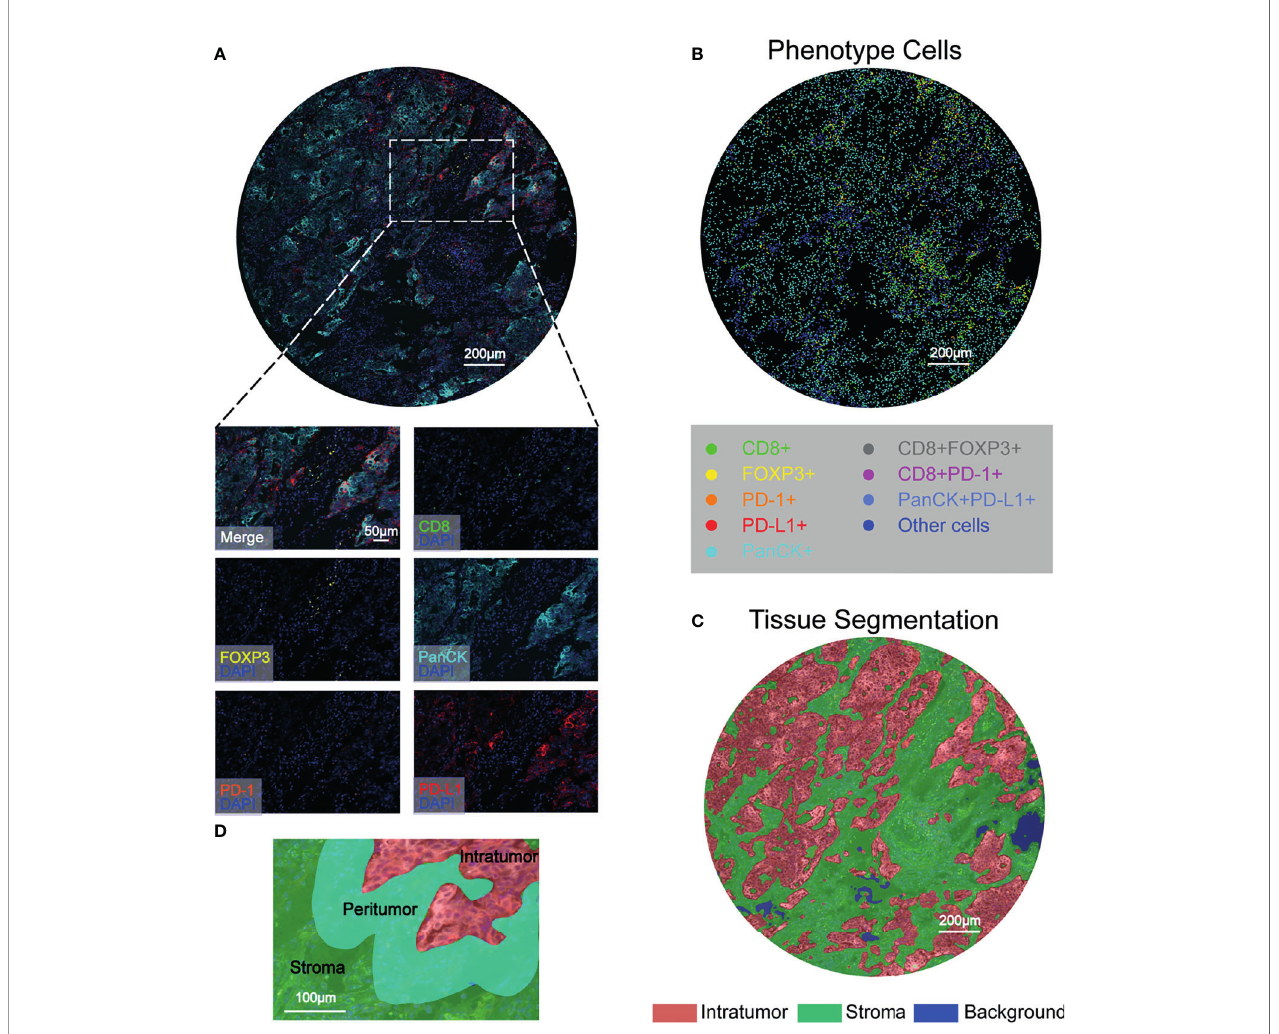
FIGURE 1 | Characterization of tumor-associated immune cells and immune checkpoints in NSCLC tissues using six-color mIHC. (A) Digital scanning produced a multispectral image (MSI) of one TMA core from NSCLC patient tissues. (B) Corresponding identi fi cation markers employed in this study. Representative images were acquired with a Vectra Polaris microscope and show multiple staining patterns in NSCLC tissues. PanCK, as a tumor cell marker, is shown in cyan; FOXP3+ T cells are shown in yellow; and PD-1+ cells are shown in orange. Red indicates PD-L1+ cells, and green indicates CD8+ cells. The multiplexed images show colocalization of different markers, such as CD8 and PD-1. Scale bar: 200 m m. (C) Segmentation of the tumor compartment into intratumor (red) and stromal (green) tissues, which were distinguished by PanCK+ cells. Scale bar: 200 m m. (D) Representative image of the peritumoral regions, which were selected for CD8+, FOXP3+, PD-1+ and PD-L1+ cell quanti fi